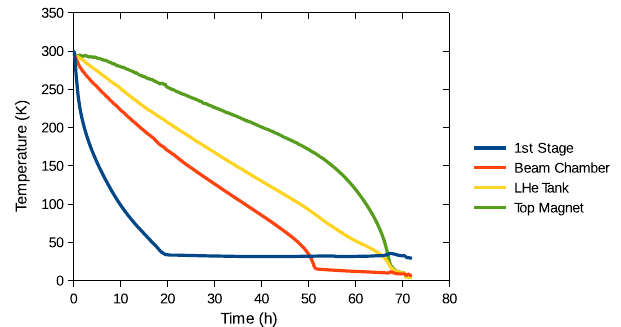
FIG. 7. Temperatures of the SCU1 components during the cooldown process: the 1st stage of 4-K cryocooler (blue); beam chamber (red); LHe tank (yellow), and the magnet top core